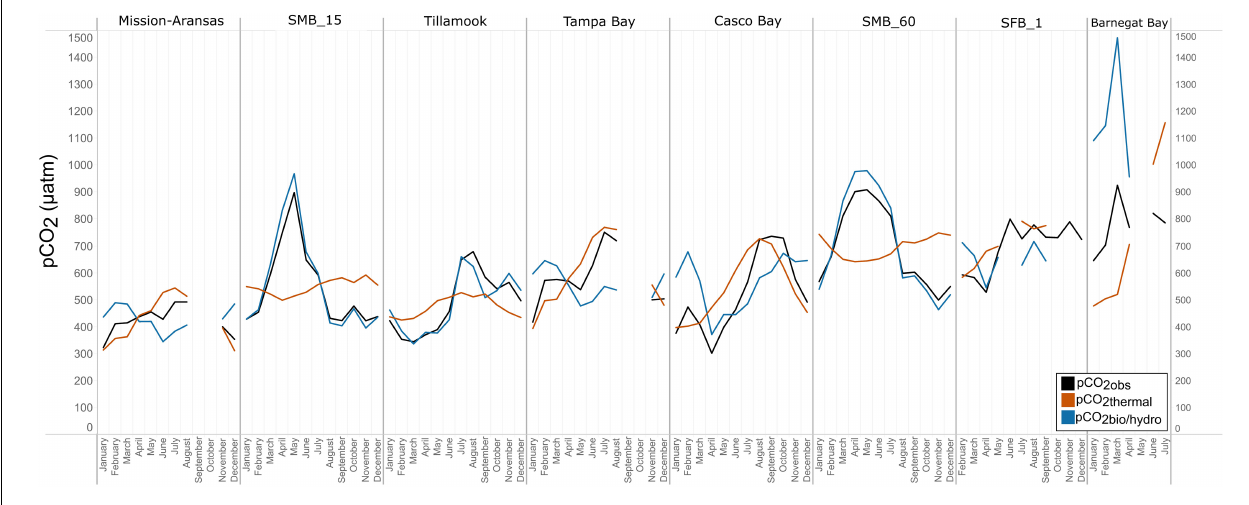
FIGURE 12 | Trends in p CO 2 obs , p CO 2 thermal , and p CO 2 bio / hydro within in each water body. Data points represent monthly averages. Black line = p CO 2 obs ; red = p CO 2 thermal ; blue = p CO 2 bio / hydro . The water bodies are arranged from lowest median p CO 2 to highest median p CO 2